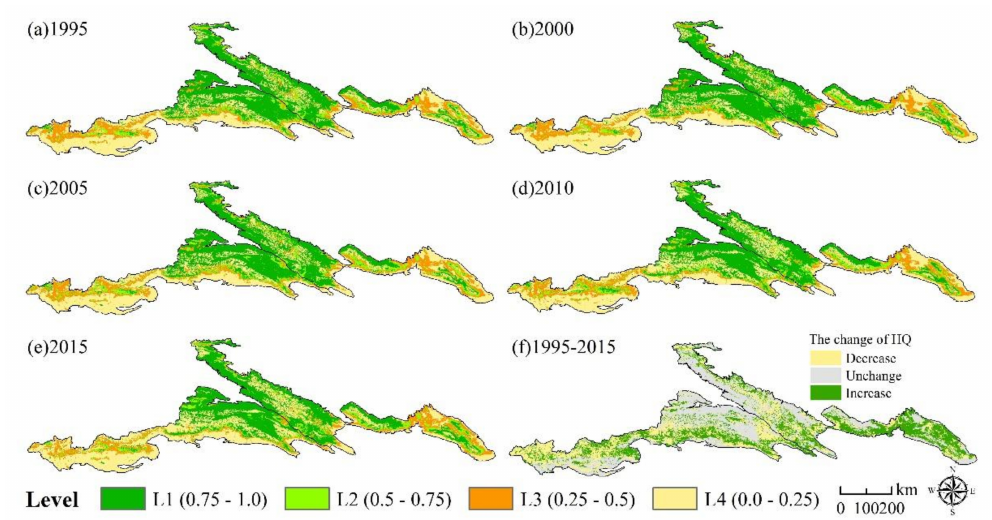
Figure 5. The change in habitat quality from 1995 to 2015. Notes: ( a )~( e ) are the spatial distribution of different habitat quality levels in 1995, 2000, 2005, 2010, and 2015, respectively; ( f ) is the change of habitat quality from 1995 to